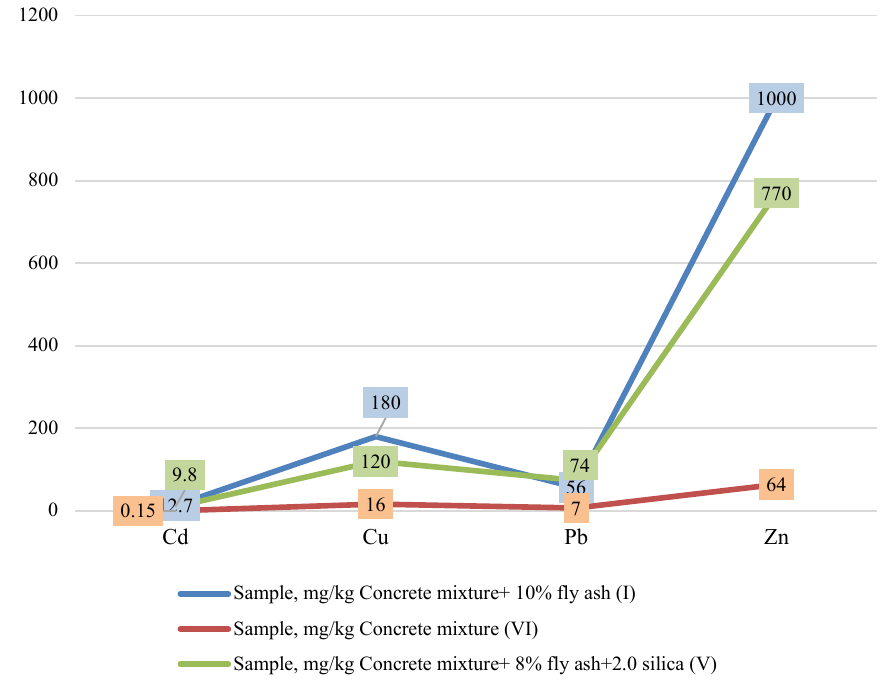
Fig. 4 Heavy metals concentration of I, V, and VI